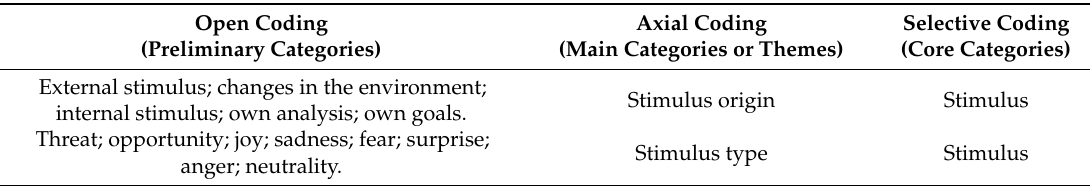
Table 1. Open, axial and selective